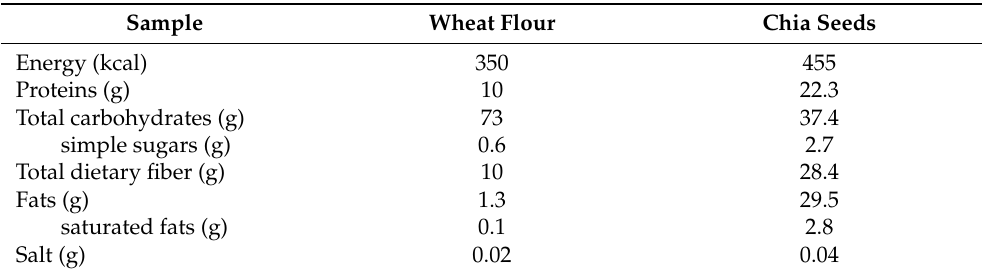
Table 2. The nutritional compositions of wheat flour and chia seeds are declared on the label package. Data are expressed per 100 g of